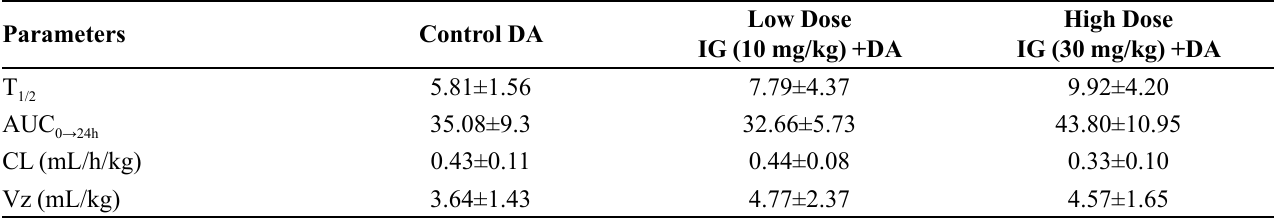
TABLE II - Comparison of pharmacokinetics parameters of diclofenac in the presence of